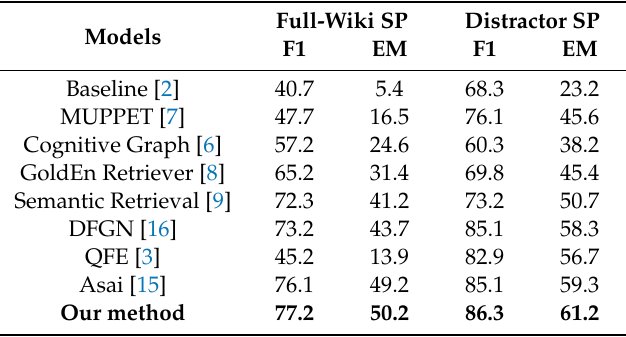
Table 1. Primary results for HotpotQA development set results: SP results on the HotpotQA’s full wiki and distractor settings. The highest value per column is marked in bold.